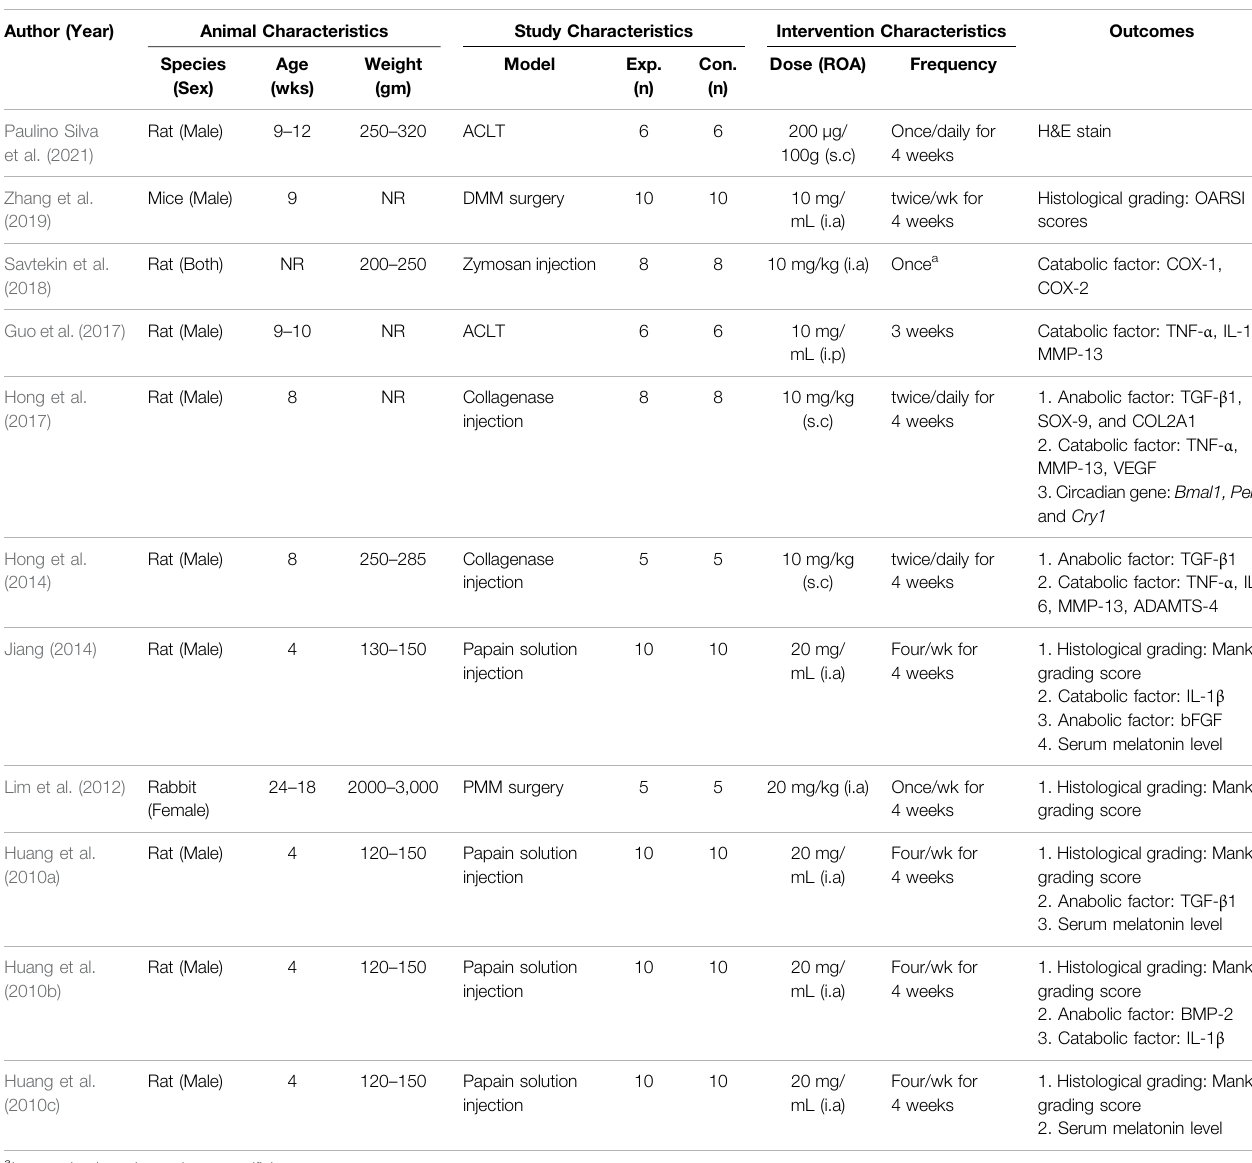
TABLE 1 | Characteristics of the included